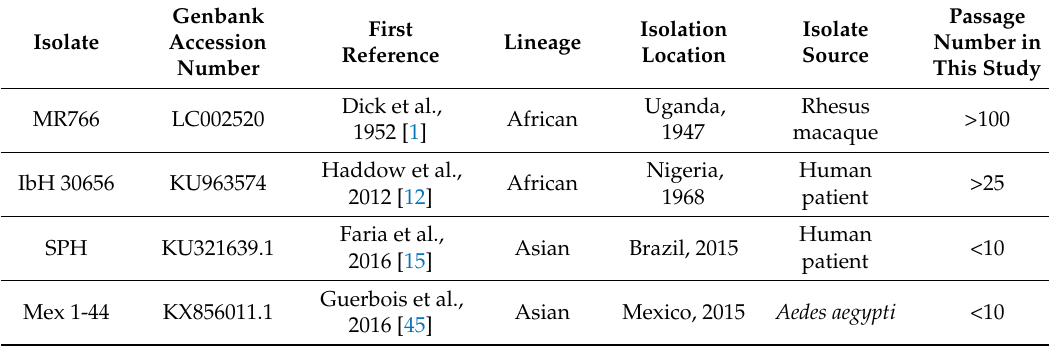
Table 1. Zika virus (ZIKV) isolates used in these